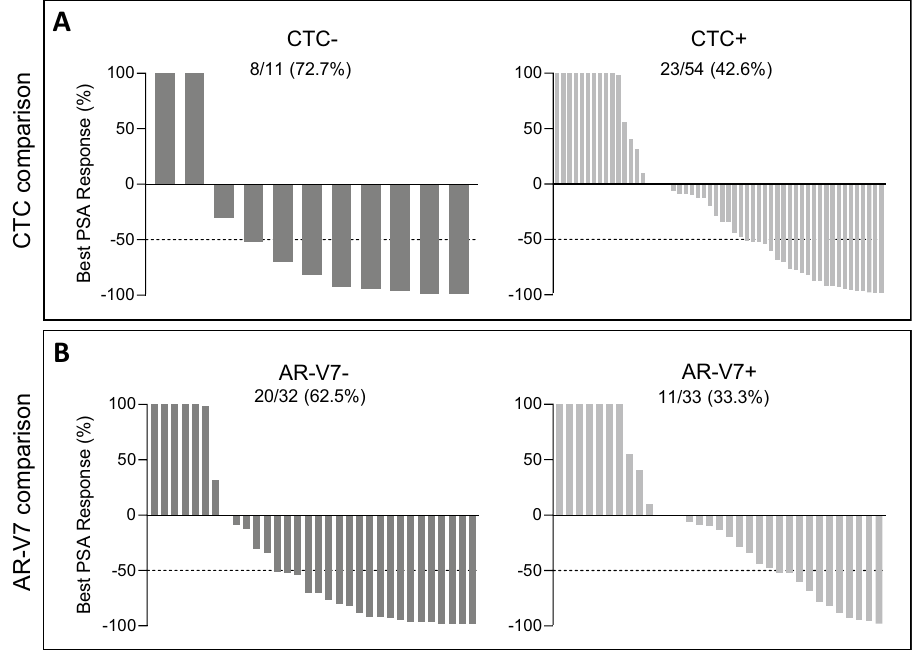
Figure 2. PSA response. Waterfall plots depicting best PSA responses in patients starting ARTA treatment according to CTC status, ( A , left panel) CTC − patients, ( A , right panel) CTC + patients, and AR-V7 status, ( B , left panel) AR-V7- patients, ( B , right panel) AR-V7 + patients. The dotted line illustrates the threshold of PSA 50% decline defining a PSA response. When comparing patients concerning CTC status, PSA response rates were 8/11 (72.7%) and 23/54 (42.6%) in CTC − and CTC + patients, respectively, without statistical significance ( p = 0.10; Fisher’s exact test). PSA response rates were 20/32 (62.5%) and 11/33 (33.3%) in AR-V7- and AR-V7 + patients, respectively ( p = 0.03; Fisher’s exact